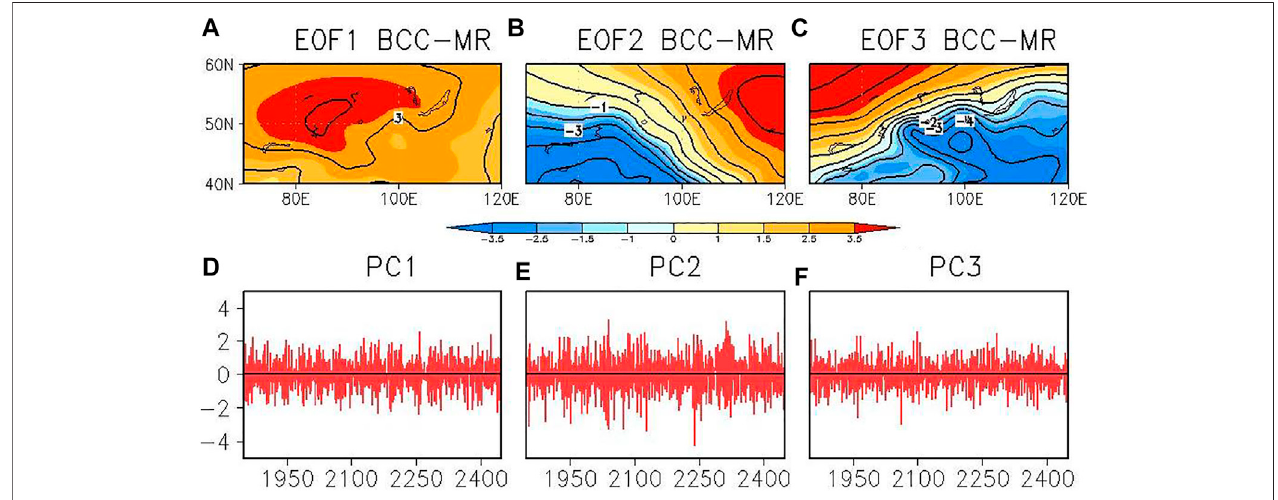
FIGURE 10 | Spatial patterns and corresponding principal components of the fi rst (A,D) , second (B,E) , and third (C,F) EOF mode of winter-mean SLP in the Siberian high domain (40 – 60 ° N, 70 – 120 ° E) from the BCC-CSM2-MR model.